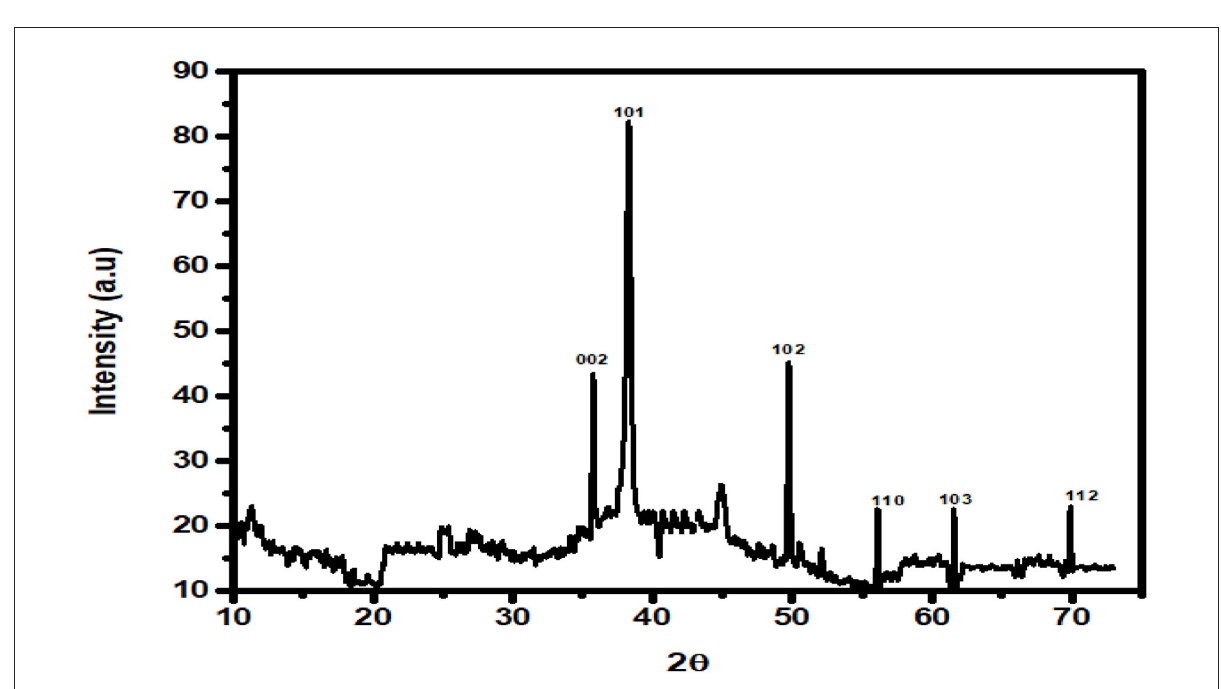
FIGURE5 XRD analysis of the green synthesized ZnO